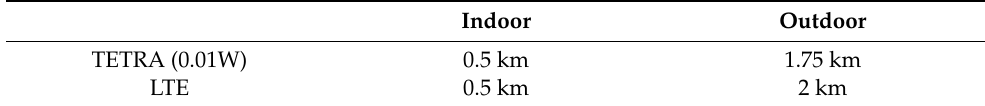
Table 3. Communication range calculation